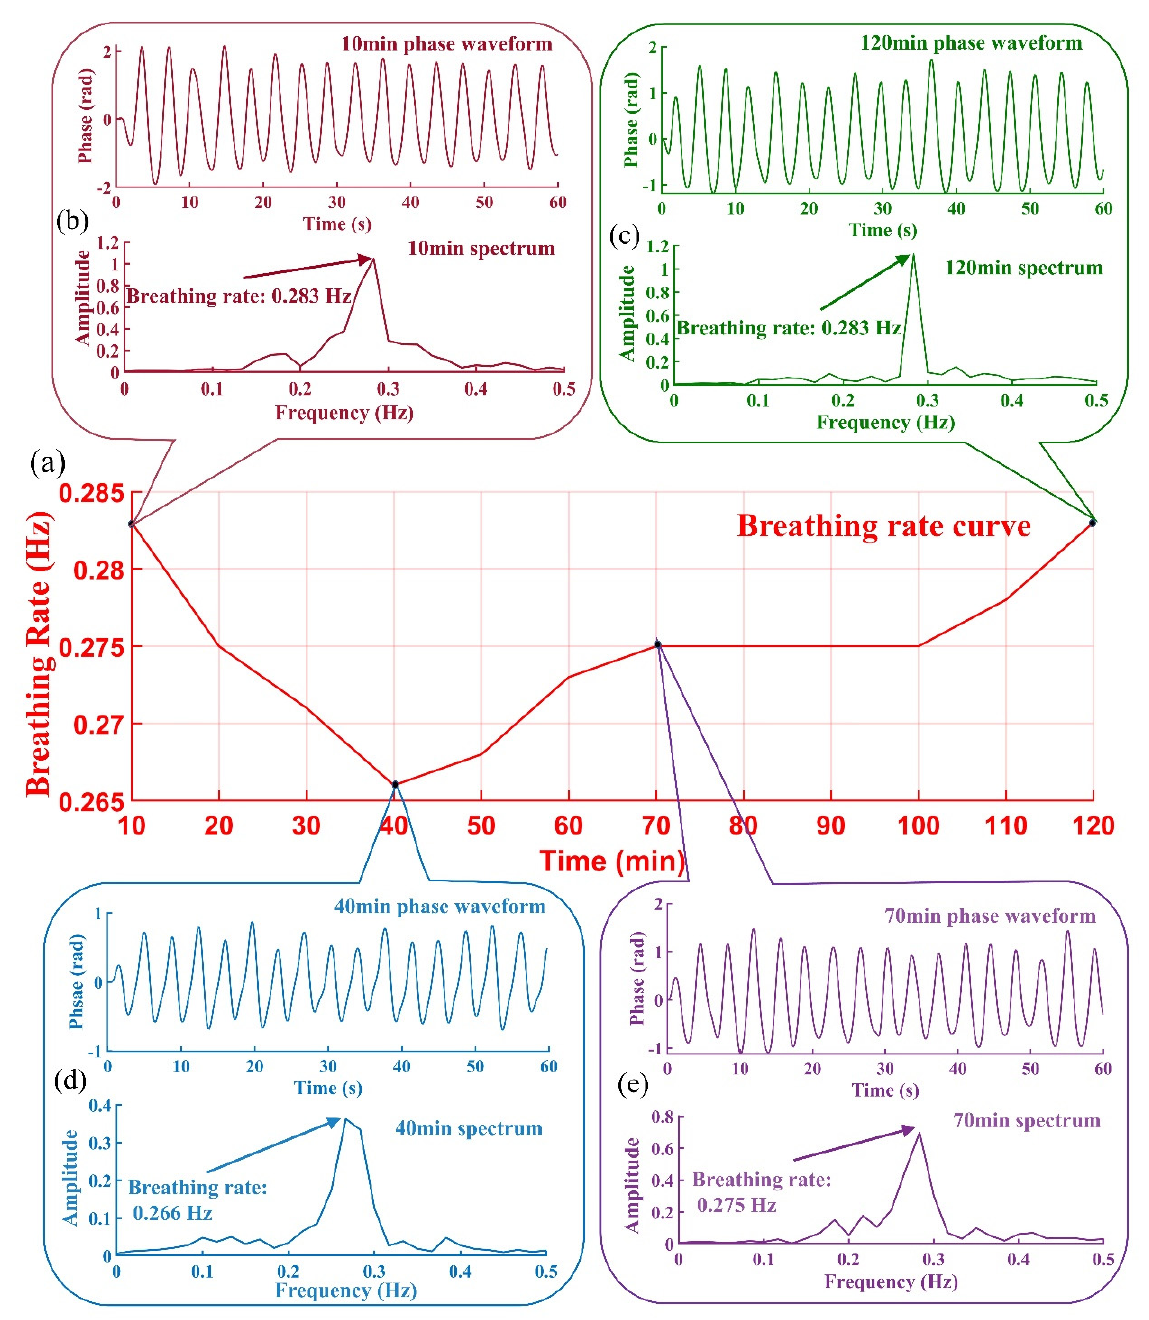
Figure 7. ( a ) Two-hour ‘normal’ breathing rate change curve; ( b ) Breathing signal phase waveform and its spectrum at 10 min; ( c ) Breathing signal phase waveform and its spectrum at 120 min; ( d ) Breathing signal phase waveform and its spectrum at 40 min; ( e ) Breathing signal phase waveform and its spectrum at 70 min.